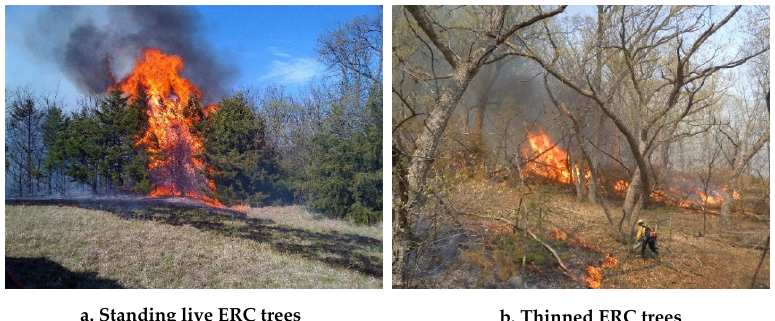
Figure 9. Highly flammable ( a ) Live ERC tree crowns and ( b ) thinned trees lying on the ground caught on fire during a controlled burn in Kansas.